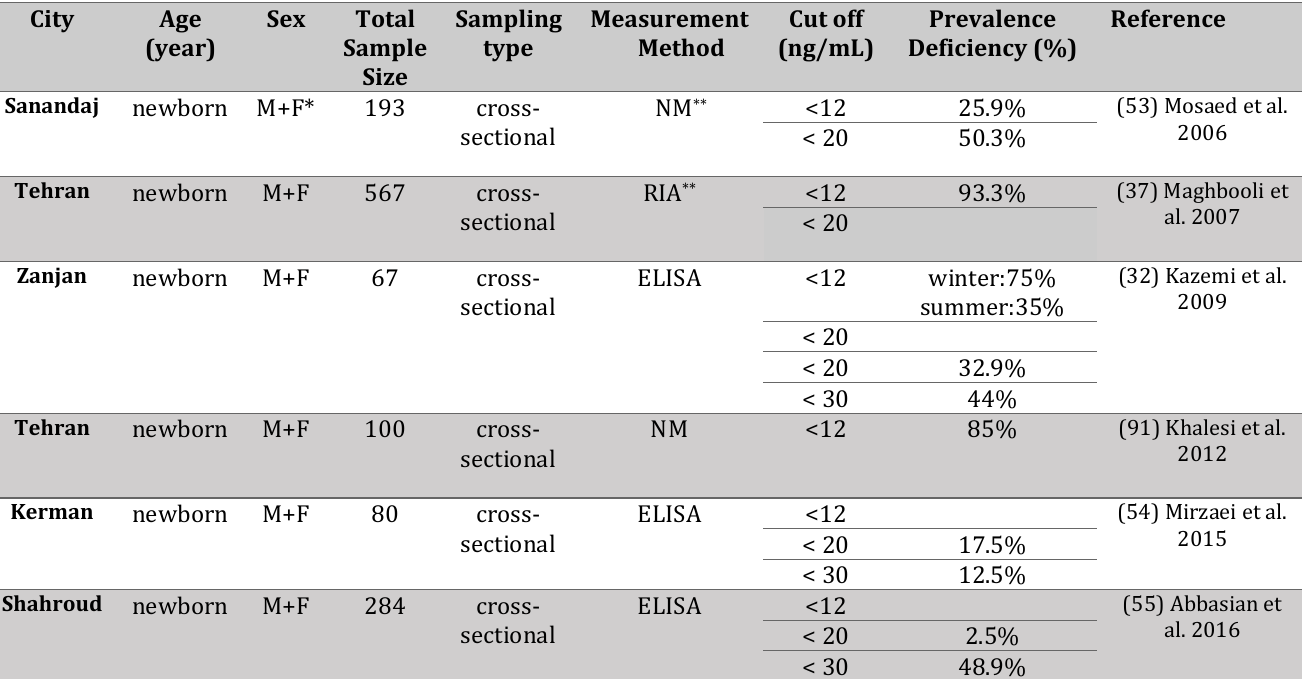
Table 2. Characteristics and main results on the prevalence of vitamin D deficiency or insufficiency in infants in